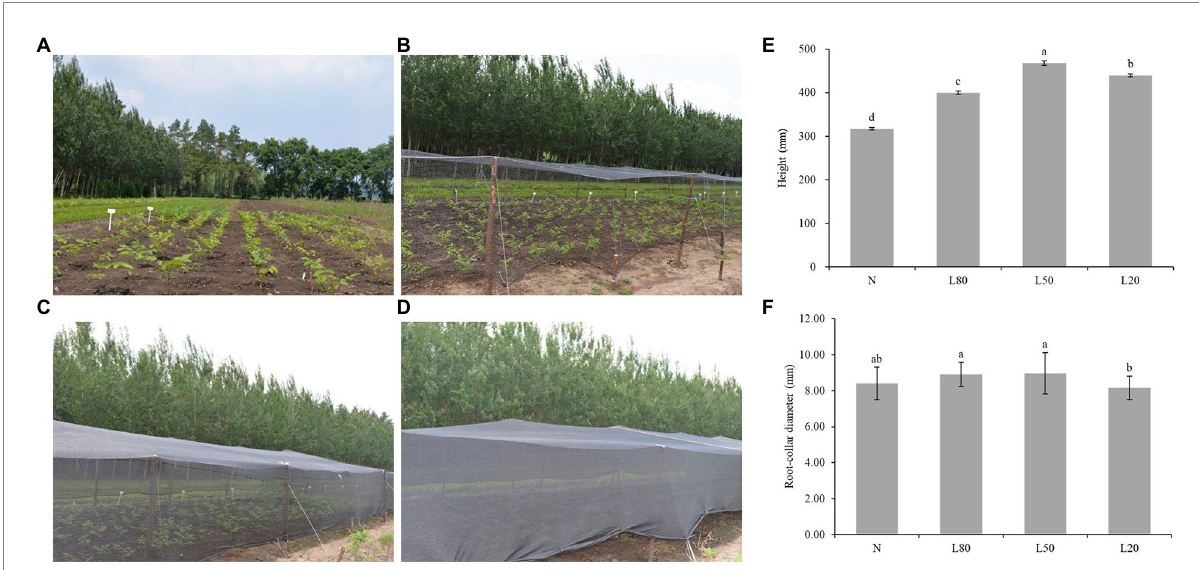
FIGURE 1 Effect of shade on the growth of J. mandshurica . J. mandshurica grown in different shade conditions, including (A) normal sunlight; (B) 80% sunlight to go through; (C) 50% sunlight to go through; (D) 20% sunlight to go through. (E) Height. (F) Root-collar diameter. N: natural sunlight. L80: 80% sunlight to go through. L50: 50% sunlight to go through. L20: 20% sunlight to go through. Error bars indicate standard deviation (SD). Different letters indicate significant differences between different